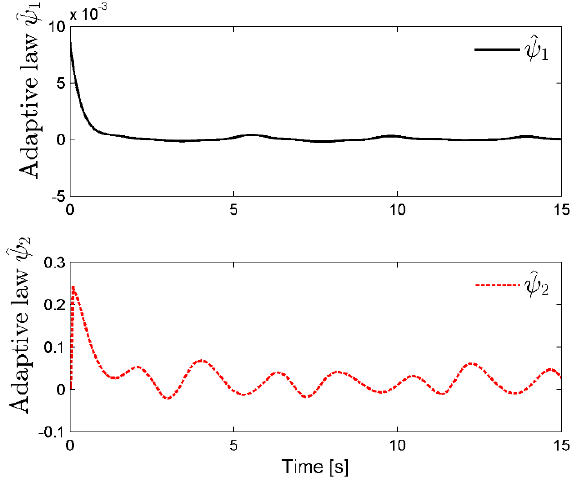
ψ ( 1,2 i = ). Figure 5. Trajectories of adaptive law ˆ ψ = 1,2). ψ ( 1,2 i = ). i ( i i i